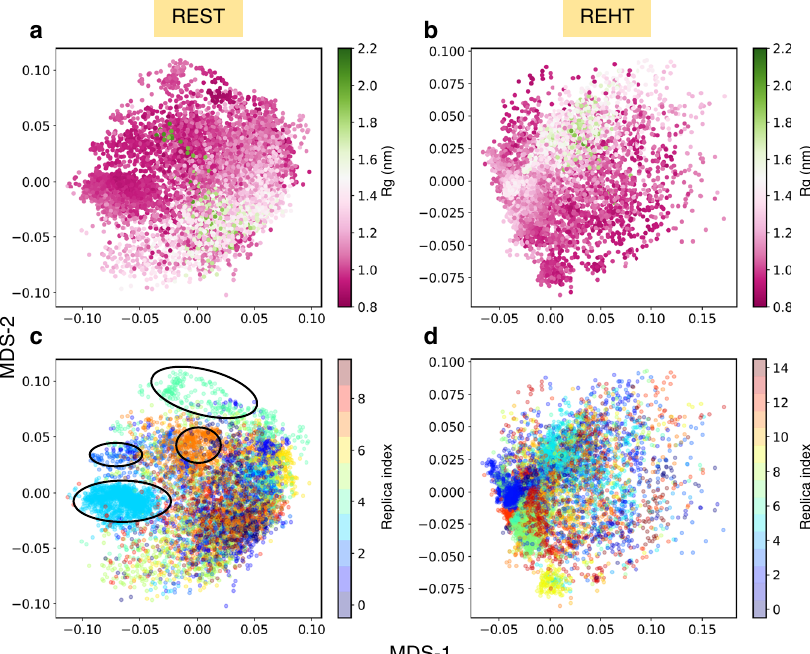
Fig. 4 Con fi gurational map of His-5 ensemble based on pairwise-dissimilarity of conformations shown across 2-dimensional MDS axes. In a , b the conformations of REST2 and REHT ensembles are colored by the respective Rg values and in c , d they are colored by replica index. Maximally separated non- overlapping clusters in REST2 as marked in c indicates the trapping of conformations in independent replicas that are eventually exchanged to base